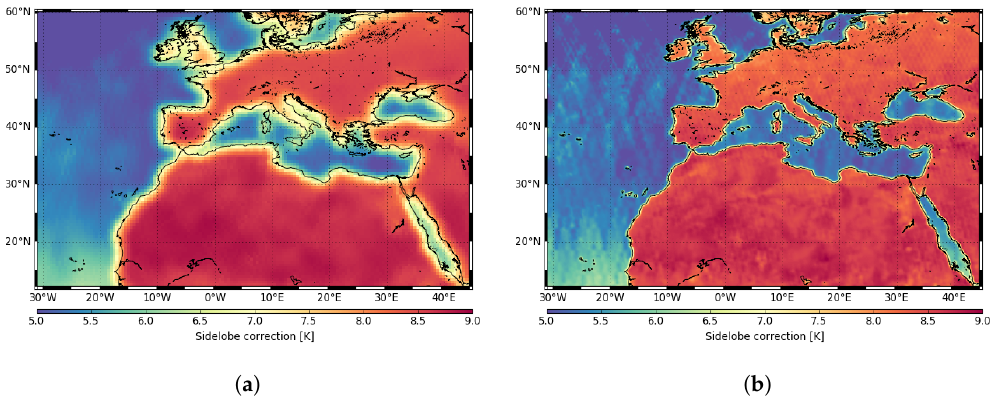
Figure 2. Side-lobe correction map centered on Mediterranean sea. ( a ) On-Earth side-lobe correction for 23.8 GHz channel computed with Envisat antenna pattern; ( b ) On-Earth side-lobe correction for 23.8 GHz channel computed with S3A antenna pattern